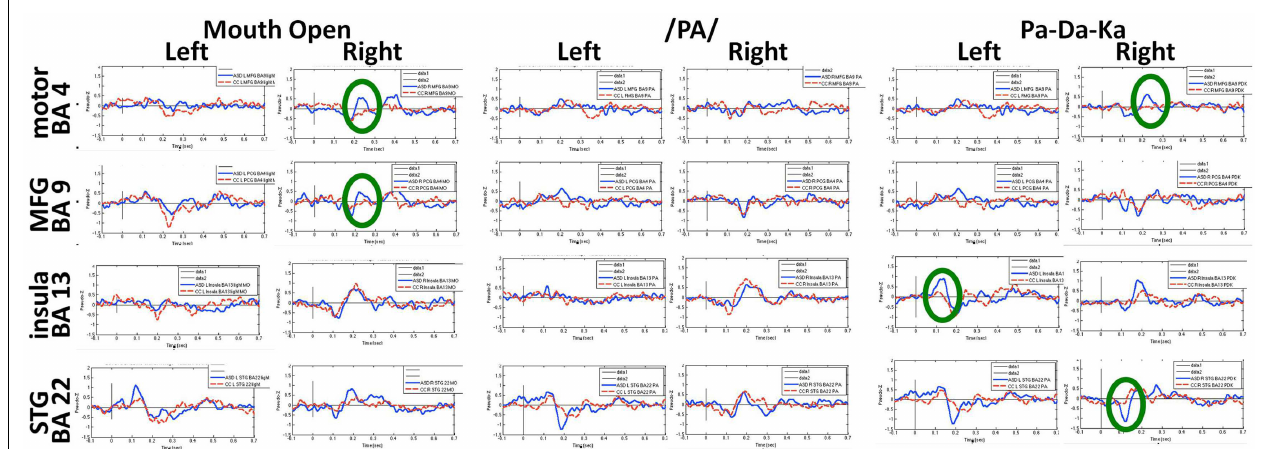
and Robinson, 2001), and peak activation in regions of interest (based on nine a priori regions identified from canonical expressive language areas, plus each homologous region) were computed and averaged by group, and then the magnitude (amplitudes) and latency analyzed for each participant and submitted to paired t -tests and corrected for multiple